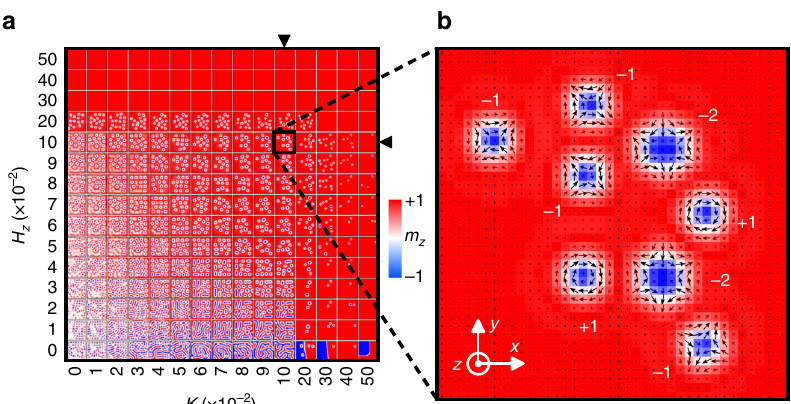
Fig. 1 Skyrmions and antiskyrmions in a frustrated J 1 - J 2 - J 3 ferromagnetic thin fi lm. a Typical metastable states obtained by relaxing the magnetic thin fi lm with a random initial spin con fi guration. b The spin con fi guration of the relaxed sample with K = H z = 0.1. The skyrmion number Q is indicated. The arrow denotes the in-plane spin components ( m x , m y ). The color scale represents the out-of-plane spin component ( m z ), which has been used throughout this paper. The model is a square element (40 × 40 spins) with the OBC. The fi xed parameters (in units of J 1 = 1) are J 2 = − 0.8 and J 3 = − 1.2. K and H z are varied between 0 and